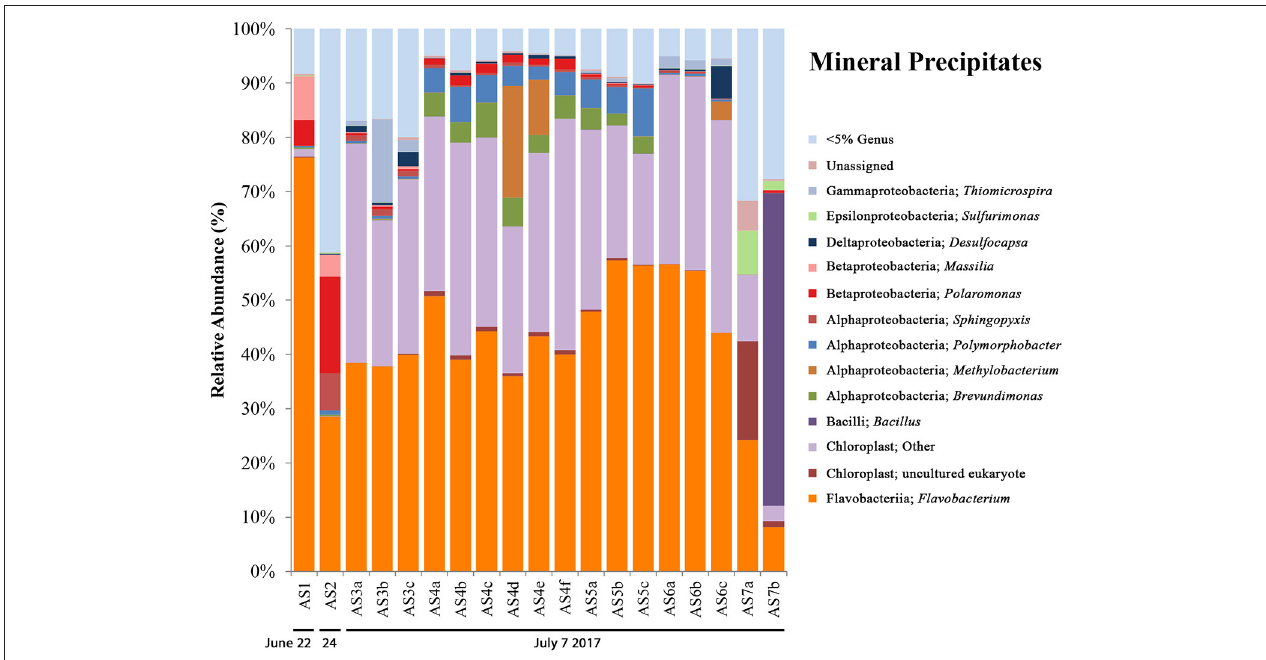
FIGURE 5 | Mineral precipitate bar charts show relative abundance of 16S rRNA gene sequencing libraries, where only OTUs representing organisms more than 5% of any given sample are labeled. All other OTUs below 5% relative abundance are grouped together in the category “Genus < 5%.” Labels show Class and subsequent Genus level. Sites are named such that any biological replicates are denoted by lowercase letters. The mineral precipitate sites are in order (from left to right) based on sampling date. Two samples are from 2014 (AS1 & AS2), while the rest are from 2017 (AS3–AS7). The 2017 sampling area is shown in Figure